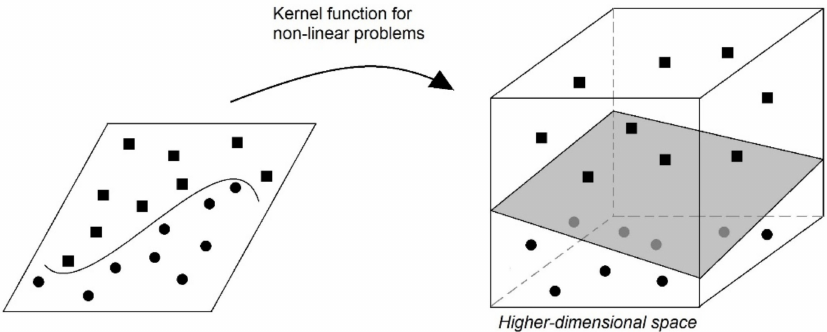
Figure 2. Illustration of the SVM principle for a non-linear problem (modified)